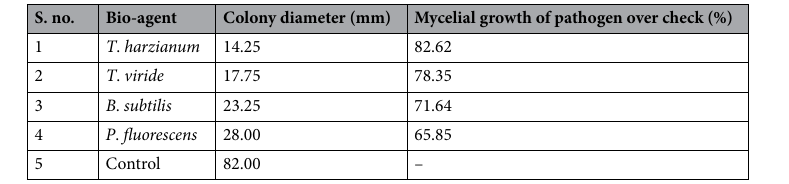
Table 2. In vitro efficacy of various bio-agents on mycelial growth inhibition of Fusarium solani. C.D ( p ≤ 0.05) = 1.48.